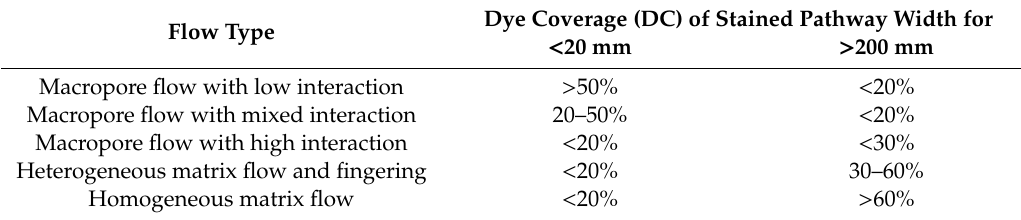
Table 2. Definition of flow type according to stained pathway width and dye coverage